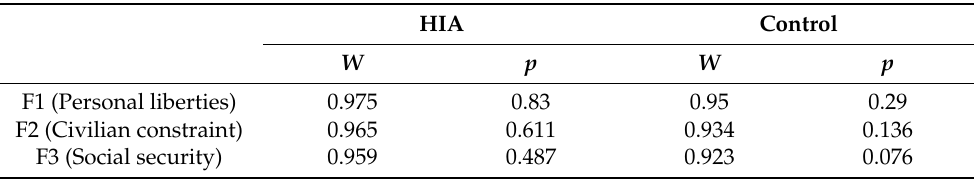
Table 4. Shapiro–Wilk normality distribution: HIA and control groups.